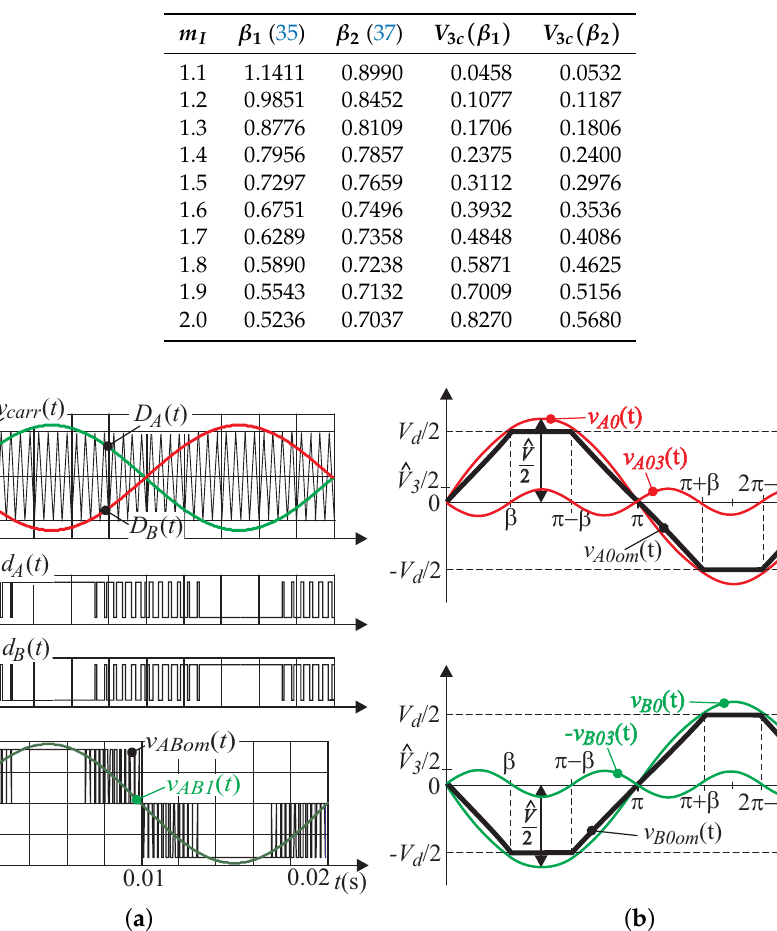
Table 1. Variations in Angle β and V 3 c During Over-Modulation.